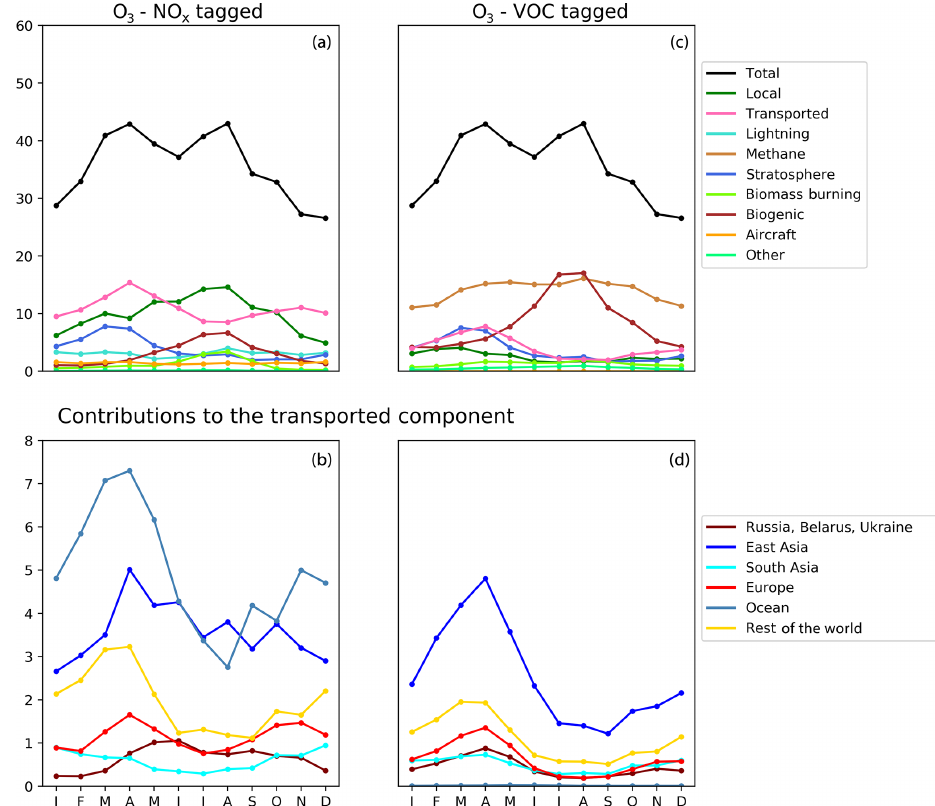
Figure 7. Seasonal cycle of surface ozone (ppb) in the HTAP Tier 2 receptor region “North West United States”. NO x tagging is shown in panels (a) and (b) , and reactive carbon tagging is shown in panels (c) and (d) . Panels (a) and (c) show the total monthly mean ozone (black line) as well as the local anthropogenic component, the long-range transported anthropogenic component, and the natural components. Panels (b) and (d) show the individual Tier 1 source regions responsible for the long-range transported component of